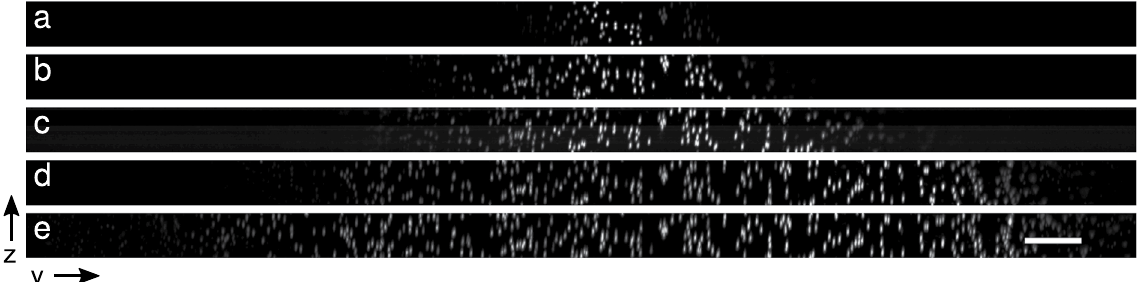
Figure 3. Maximum intensity projection along x axis of a centre region of a scan of 0.4 μ m diameter green fluorescing polystyrene microspheres embedded in agarose with different illumination parameters: ( a ) Gaussian light sheet, ( b – e ) Airy light sheet with increasing α parameter (3.5, 7, 14, and 21) for cubic phase modulation depth. Imaged in two-photon mode using the Core Laser oscillator, illumination from left. Scale bar 20 μ m.